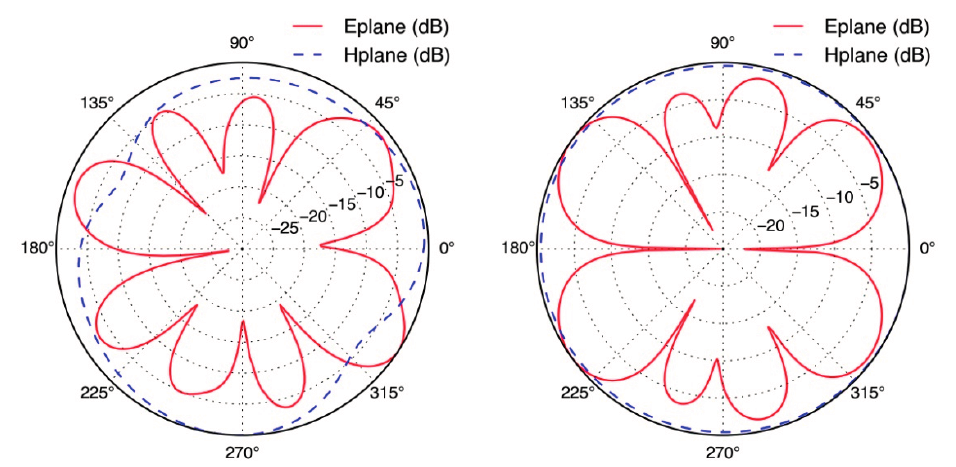
Figure 6. Measured ( Left ) and simulated ( Right ) radiation patterns along the E-plane and H-plane polarizations of the LCX textile fiber operating at 2.4 GHz